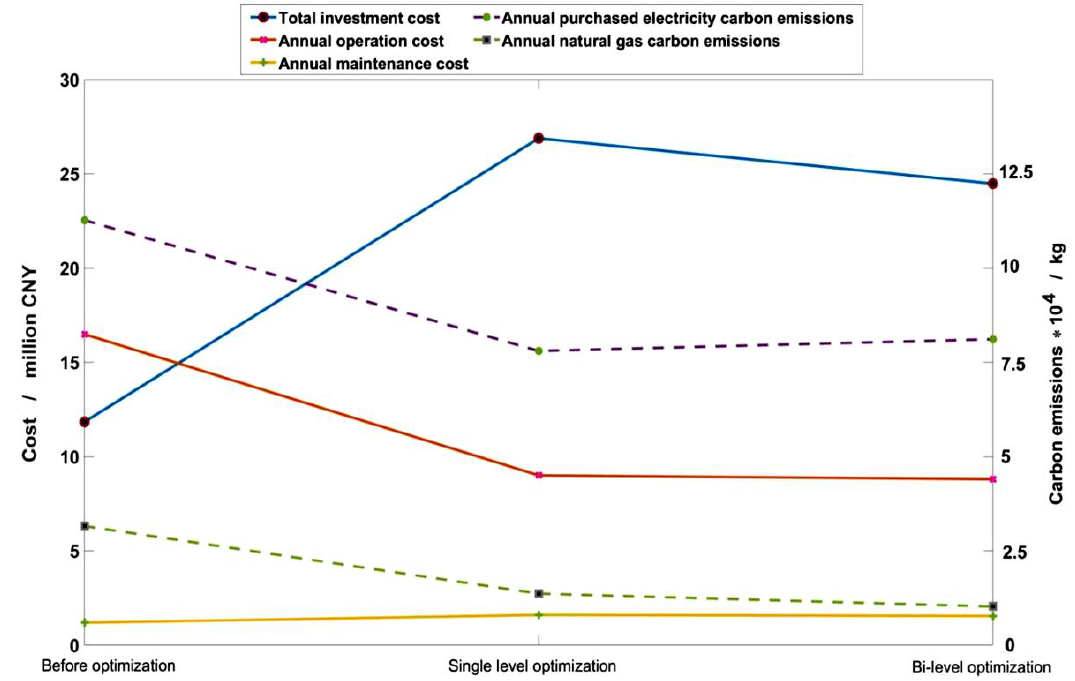
Figure 10. Comparison of before and after optimization of the example MCS.